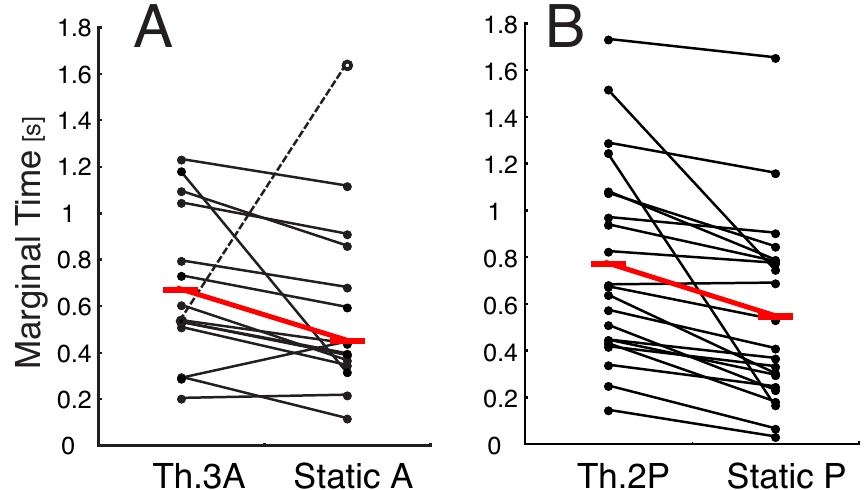
Figure 4 . Time from the step prediction until the actual step for the static predictors and for the dynamic predictor with Th.3A for anterior perturbation (A) and Th.2P for posterior perturbation (B). Each plot indicates one single trial in which the subject made a step. For each trial, the marginal time for the dynamic predictor and for the static predictor were calculated. The horizontal red bars represent the average values of the group. Note that the outlier indicated as the open circle in A was eliminated when the average value was